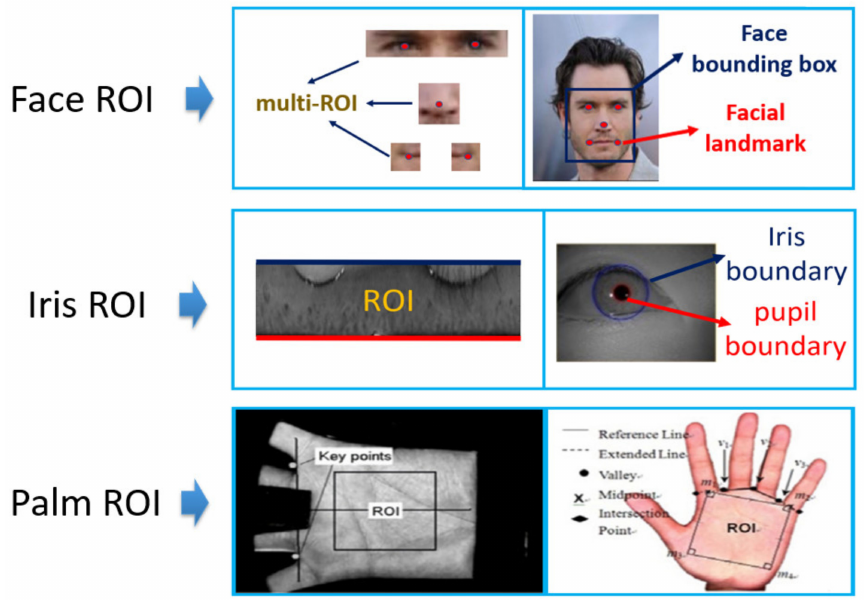
Figure 1. Various ROIs in